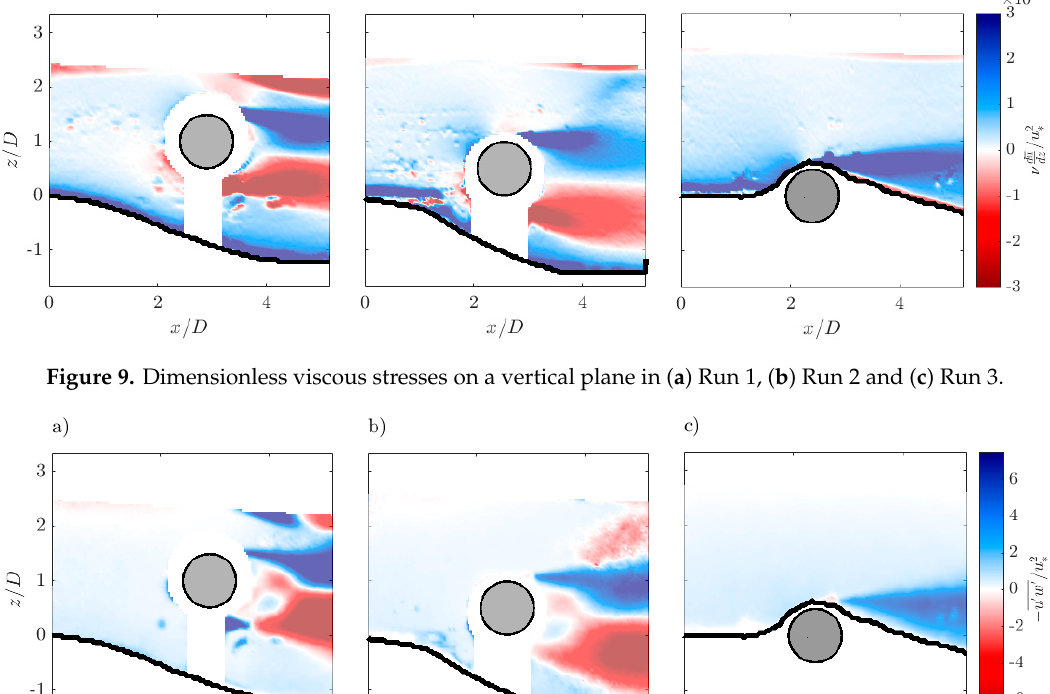
Figure 9. Dimensionless viscous stresses on a vertical plane in ( a ) Run 1, ( b ) Run 2 and ( c ) Run 3.